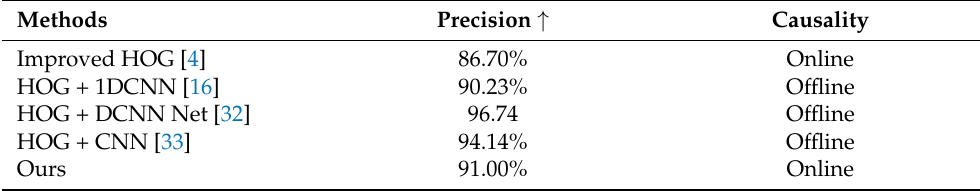
Figure 4. The left ( a ) shows the scatter plot of each instance and label associates, and ( b ) illustrates the correlation relations on the passageway scenes images dataset. Mostly, 92% of the instances are correctly associated with the labels throughout the scenes. Table 1. Comparison with state-of-the-art methods based on MOT Classification Accuracy.